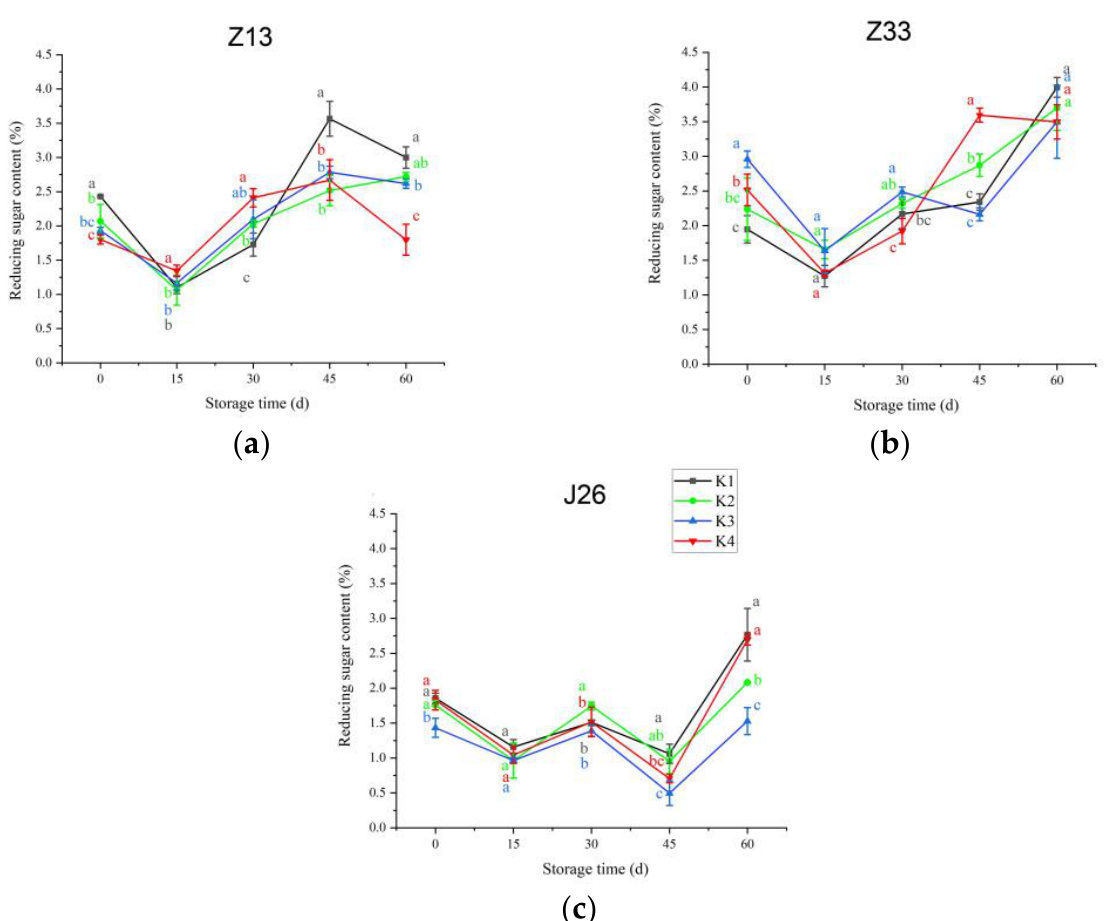
Figure 7. Reducing sugar content of different UCZ treatments during storage. ( a ) Z13; ( b ) Z33; ( c ) J26.Values within the same storage day followed by the same letter are not significantly different at the 5% level according to ANOVA-Duncan’s multiple range test. K1: Normal basal fertilizing without UCZ; K2: Normal basal fertilizing with UCZ; K3: Rich basal fertilizing without UCZ; K4: Rich basal fertilizing with UCZ.